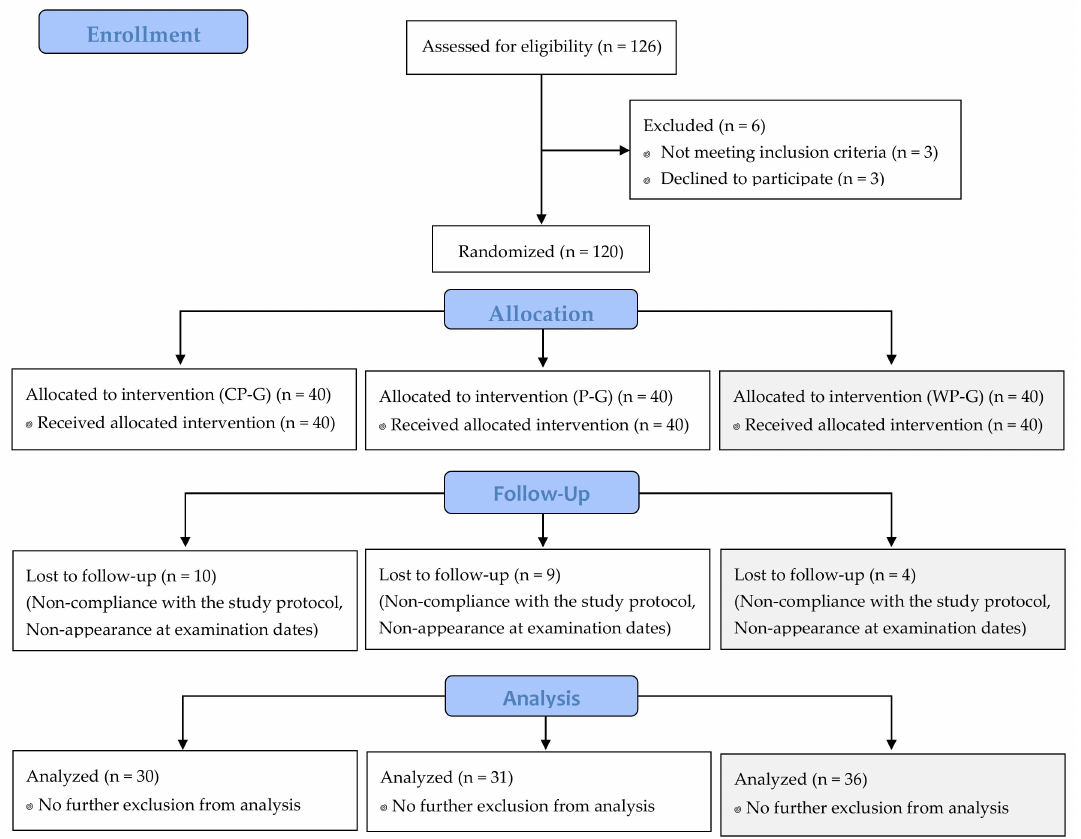
Figure 1. Flow chart of subject recruitment, randomization and